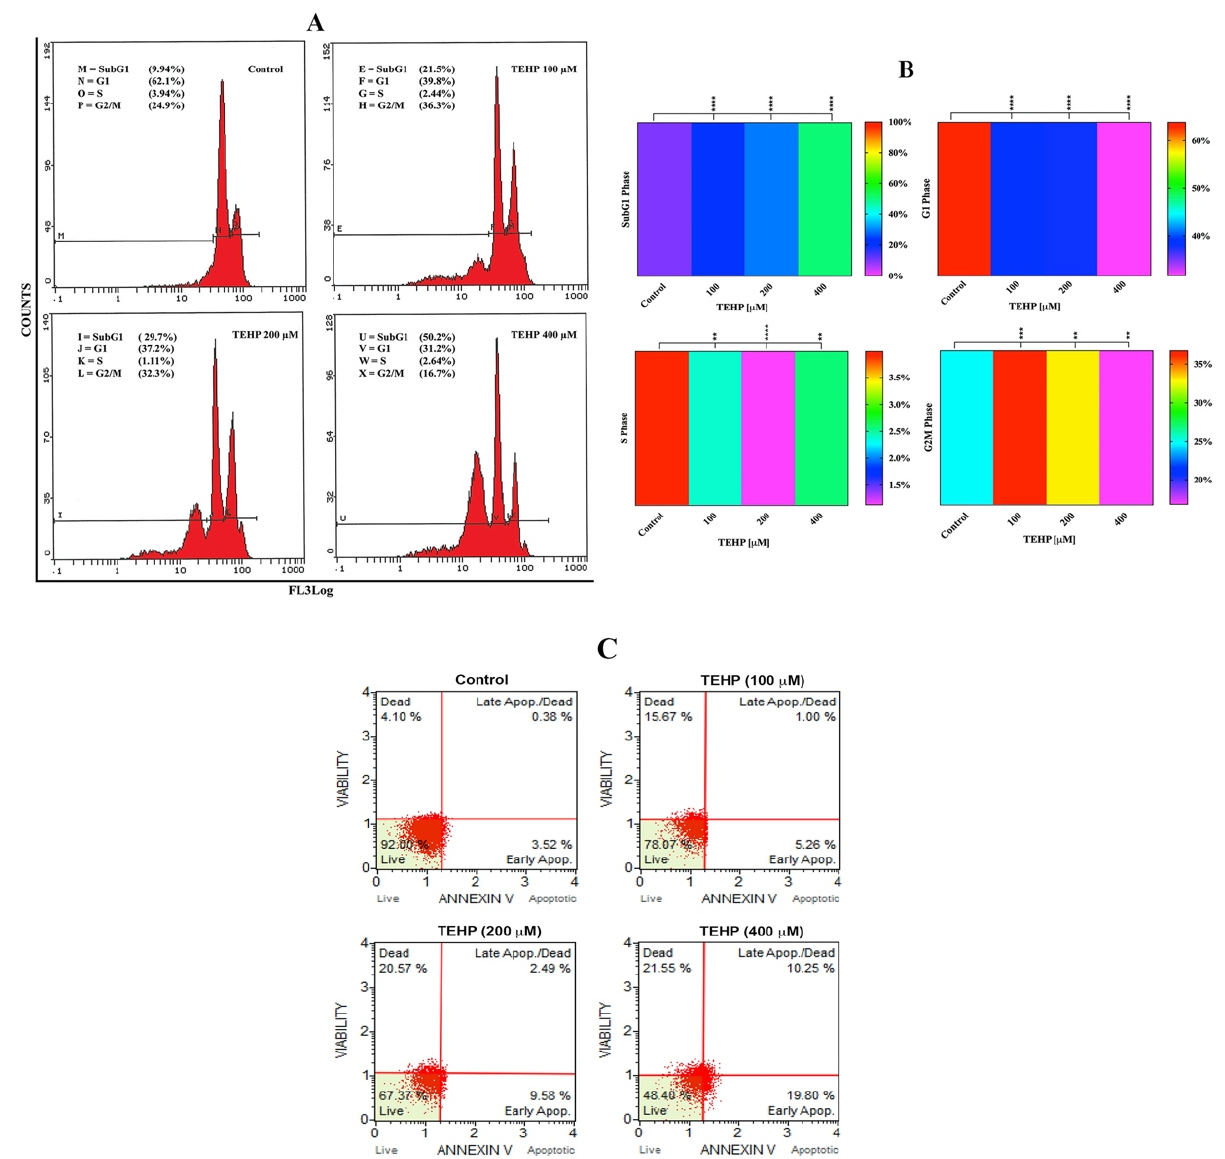
Figure 4. Flow cytometric quantification of cell cycle phases in HepG2 cells exposed to TEHP for 72 h. ( A ) Representative cell cycle images from TEHP-treated HepG2 cells showing a concentration dependent increase in the apoptotic peak (SubG1). ( B ) Cumulative data of all phases are depicted as heat map derived from three independent experiments carried out in triplicate wells. SubG1, G1 and S phases ( **** p < 0.0001); S phase (** p 0.0017 Control vs. 100, ** p 0.0038 Control vs. 400); G2M phase (*** p 0.0006 Control vs. 100, ** p 0.0067 Control vs. 200, ** p 0.0072 Control vs. 400). ( C ) Early apoptotic, late-apoptotic and dead cells quantification in control and TEHP-treated cells after 72